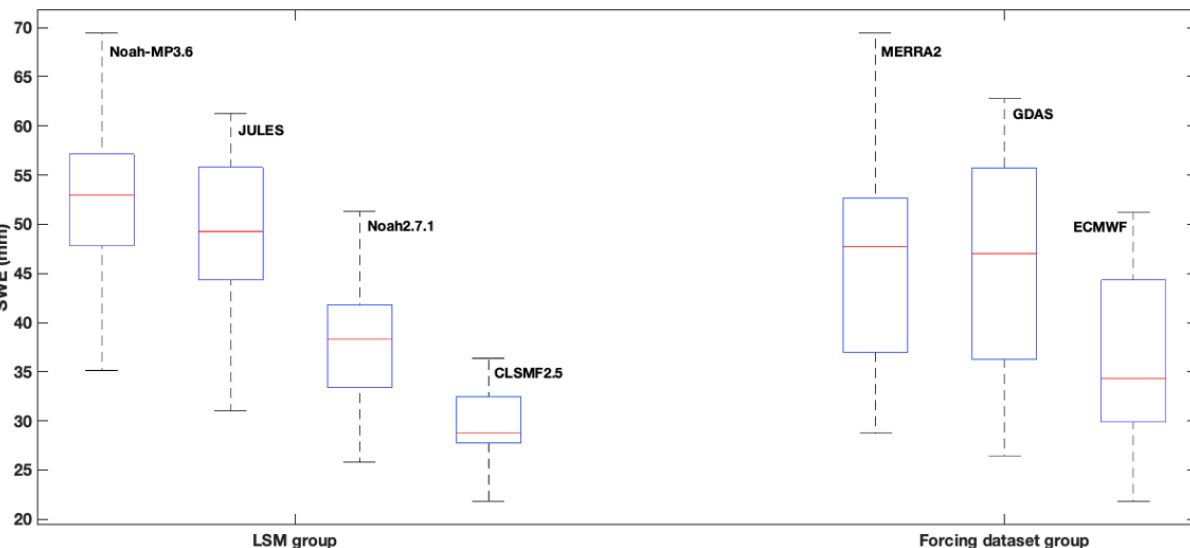
Figure 6. Distribution of North America mean annual average of SWE (i.e., interannual variability), grouped by the LSMs and forcing datasets (e.g., the box of Noah-MP3.6 represents the distribution of mean SWE, averaged from Noah-MP3.6 runs with all forcing datasets; the box of MERRA2 represents the distribution of mean SWE, averaged from all LSM runs with MERRA2 forcing data). For the LSM group, we used eight annual averages of SWE (from 2009 to 2017) for three different forcing datasets (a total of 8 × 3). For the forcing dataset group, eight annual averages of SWE for four different LSMs (total of 8 × 4) were used. The red line indicates SWE median; top and bottom of box are the 75th and 25th percentiles, and top and bottom of whiskers represent the maximum and minimum SWE with outliers (defined as more than 1.5 times the interquartile range, between 25% and 75%)